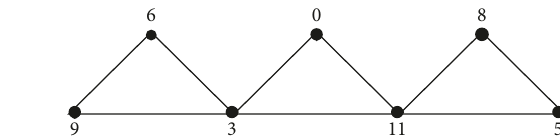
Figure 1: The radio number of Δ